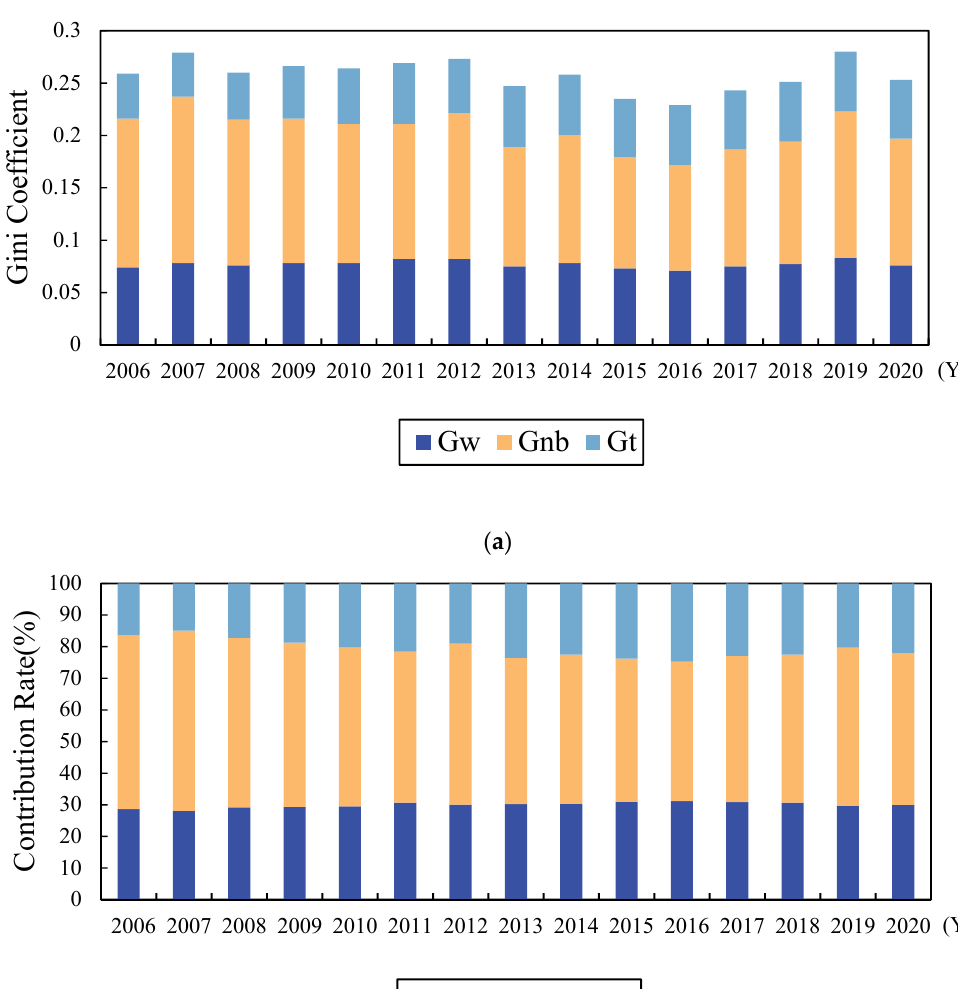
Figure 5. Spatial differences and sources in the livelihood resilience of rural residents in China: ( a ) contribution value; ( b ) contribution rate. Source: the authors’ own work.